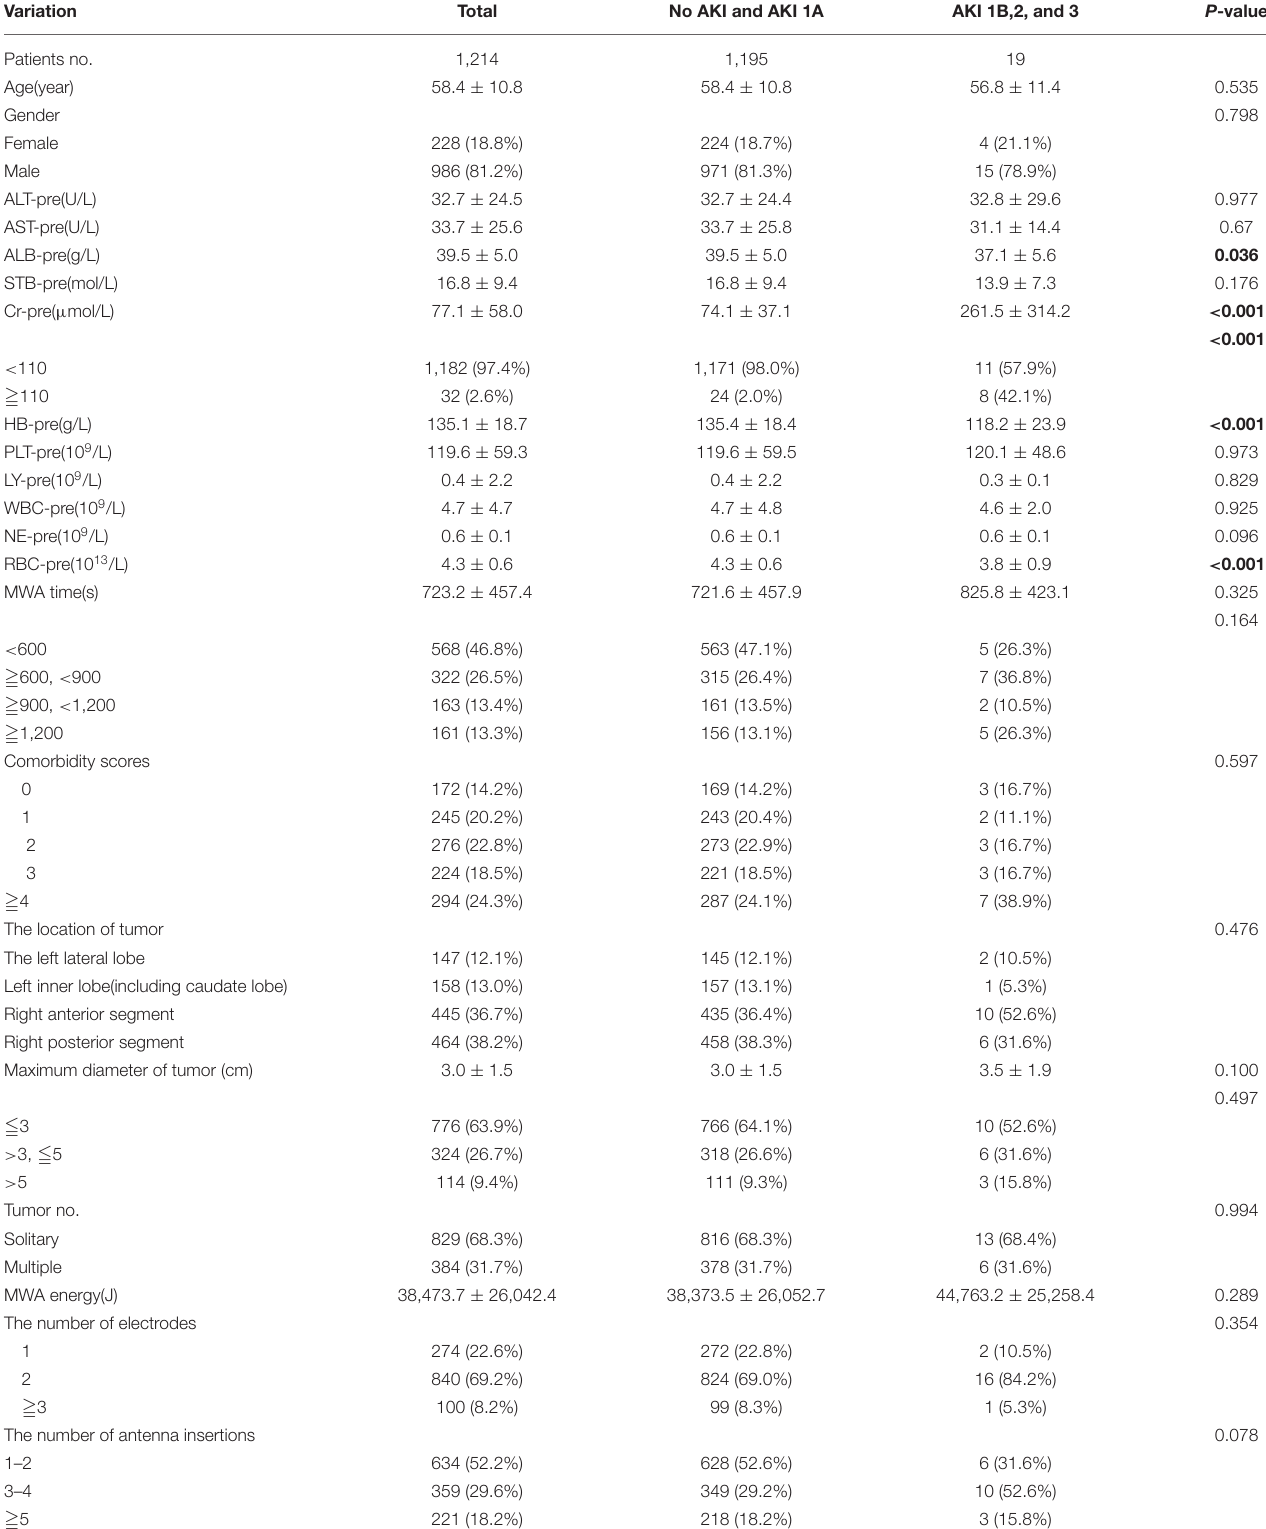
TABLE 1 | Baseline characteristic of acute kidney injury (AKI) (stages 1b, 2, and 3). Variation Total